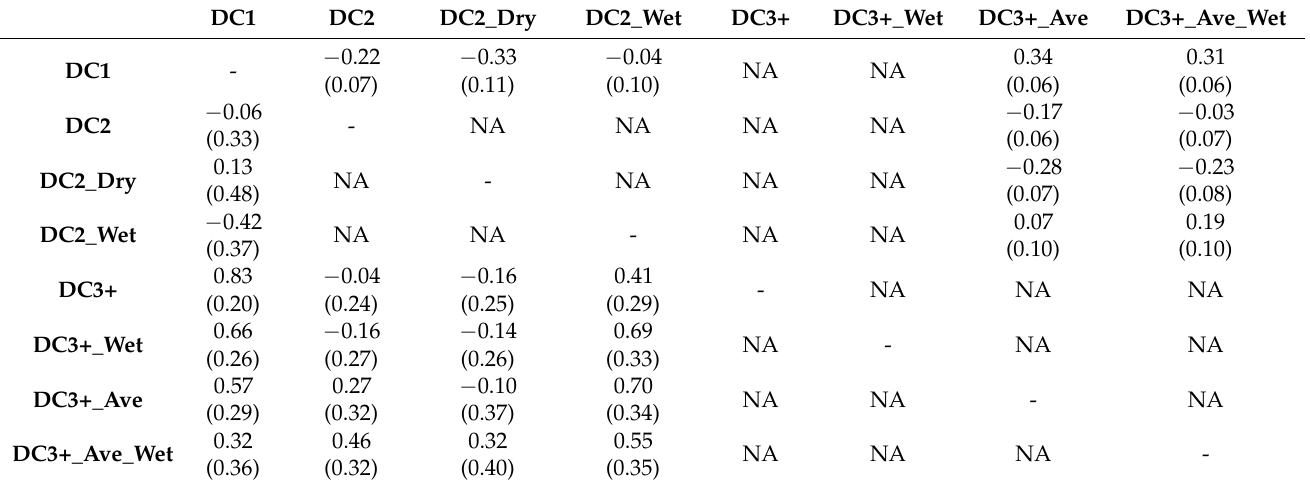
Table 14. Correlations between days to calving traits. Genetic correlations below and phenotypic correlations above the diagonal with standard errors in parenthesis.